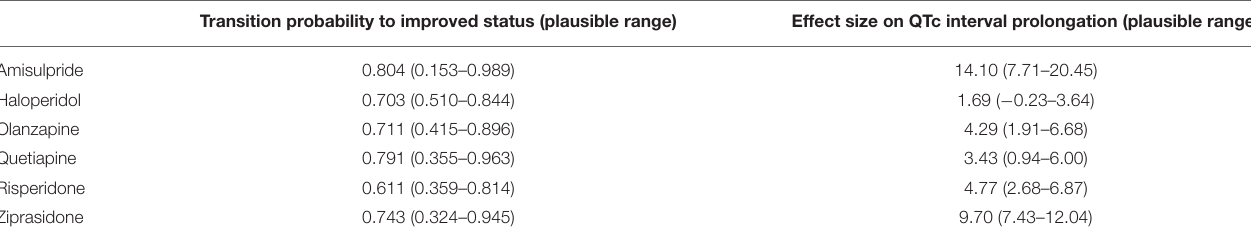
TABLE 1 | Effect size obtained from the literature (18, 22).